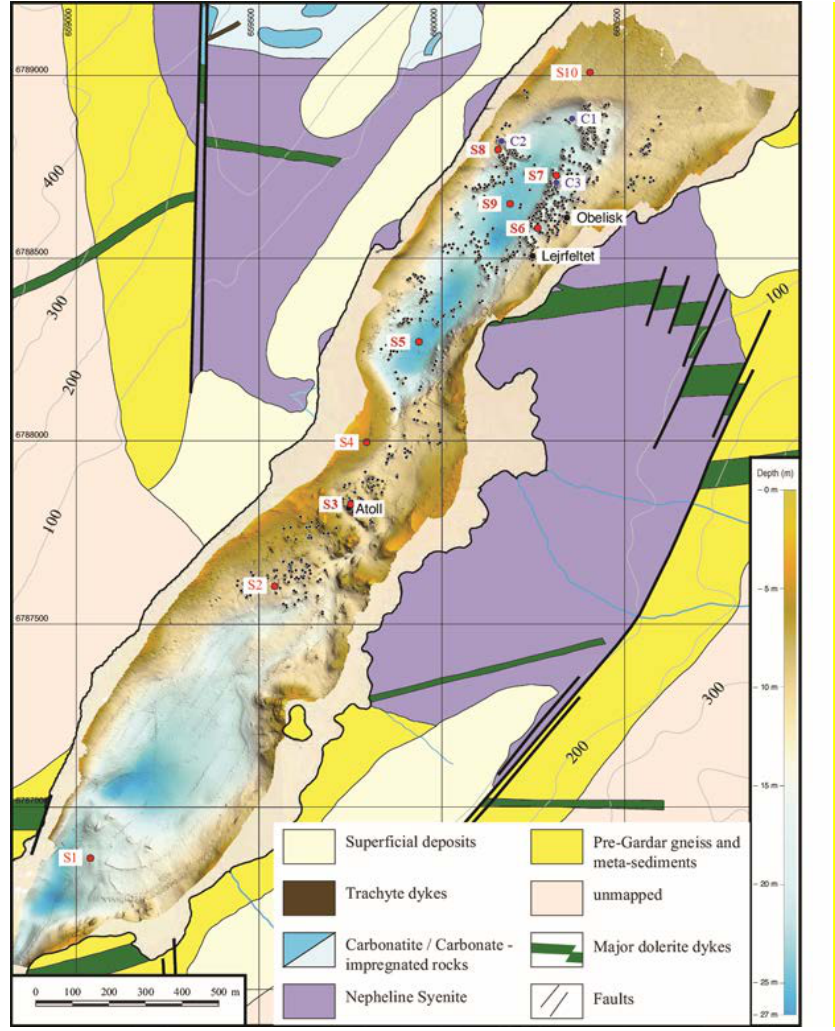
Figure 2. Bathymetric map of Ikka Fjord showing all positions of columns and marks the three areas where column samples were taken in 2019, plus the positions of the ten HOBO dataloggers, and of the Atoll and the Obelisk column areas.